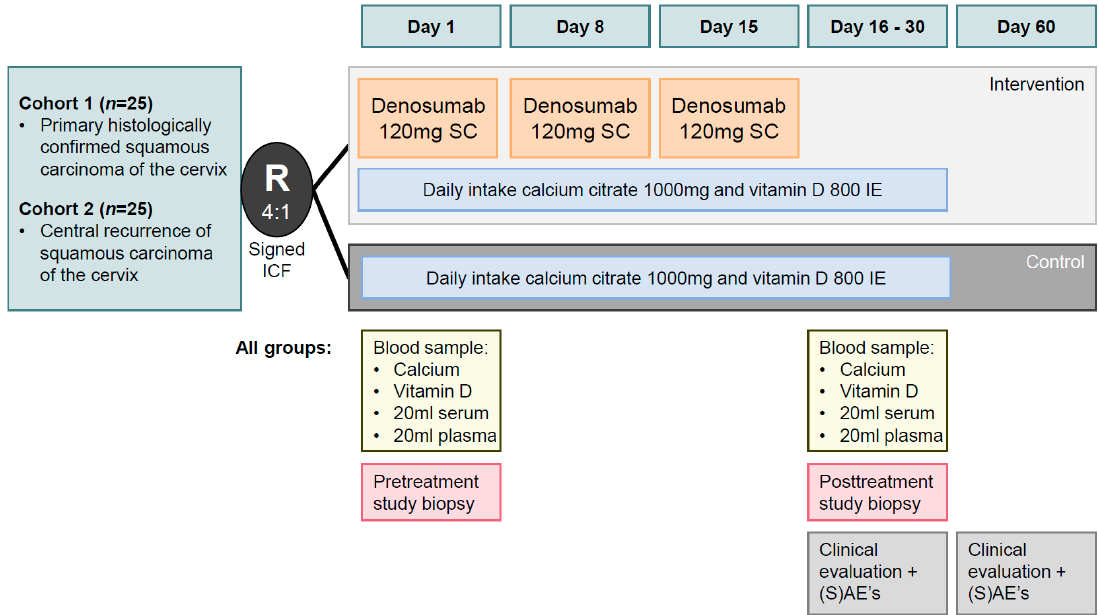
Figure 2. Outline of the DICER protocol: A window of opportunity neoadjuvant phase II study assessing the therapeutic potential of RANK/RANKL signaling inhibition in patients with primary and recurrent squamous carcinoma of the uterine cervix (ISS 20177041).